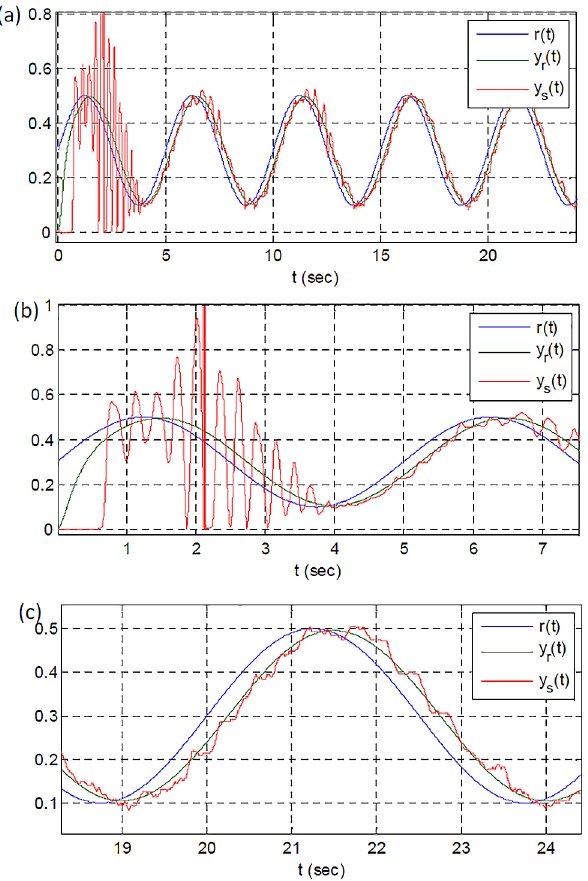
Fig 16. Sinusoidal reference input, output of reference model and output of coaxialrotors control; (a) a full view of experimental results; (b) a close view for initial response(Before adaptation);(c) a close view of final responses of the experimental system (After